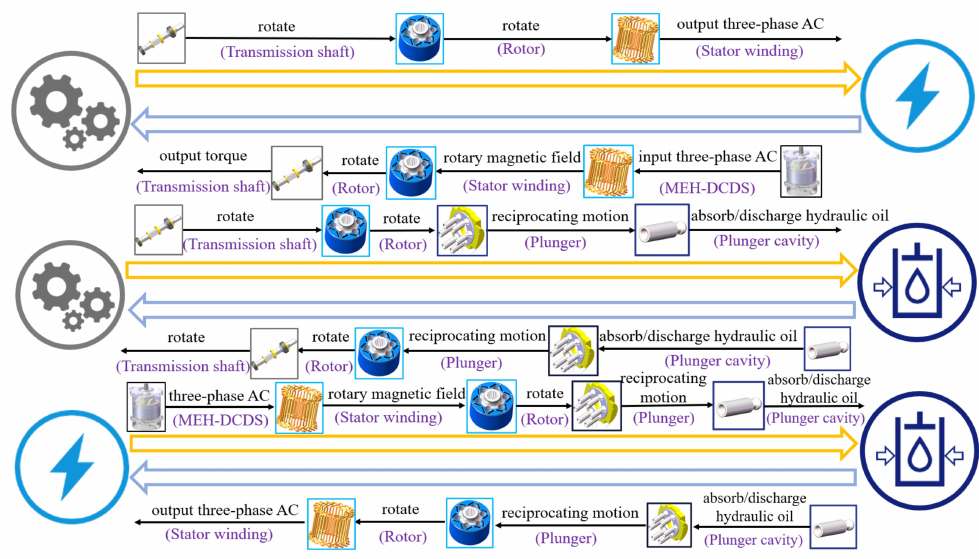
Figure 2. Energy conversion diagram of